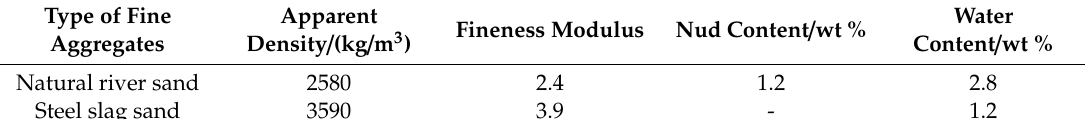
Table 6. Physical properties of fine aggregates.